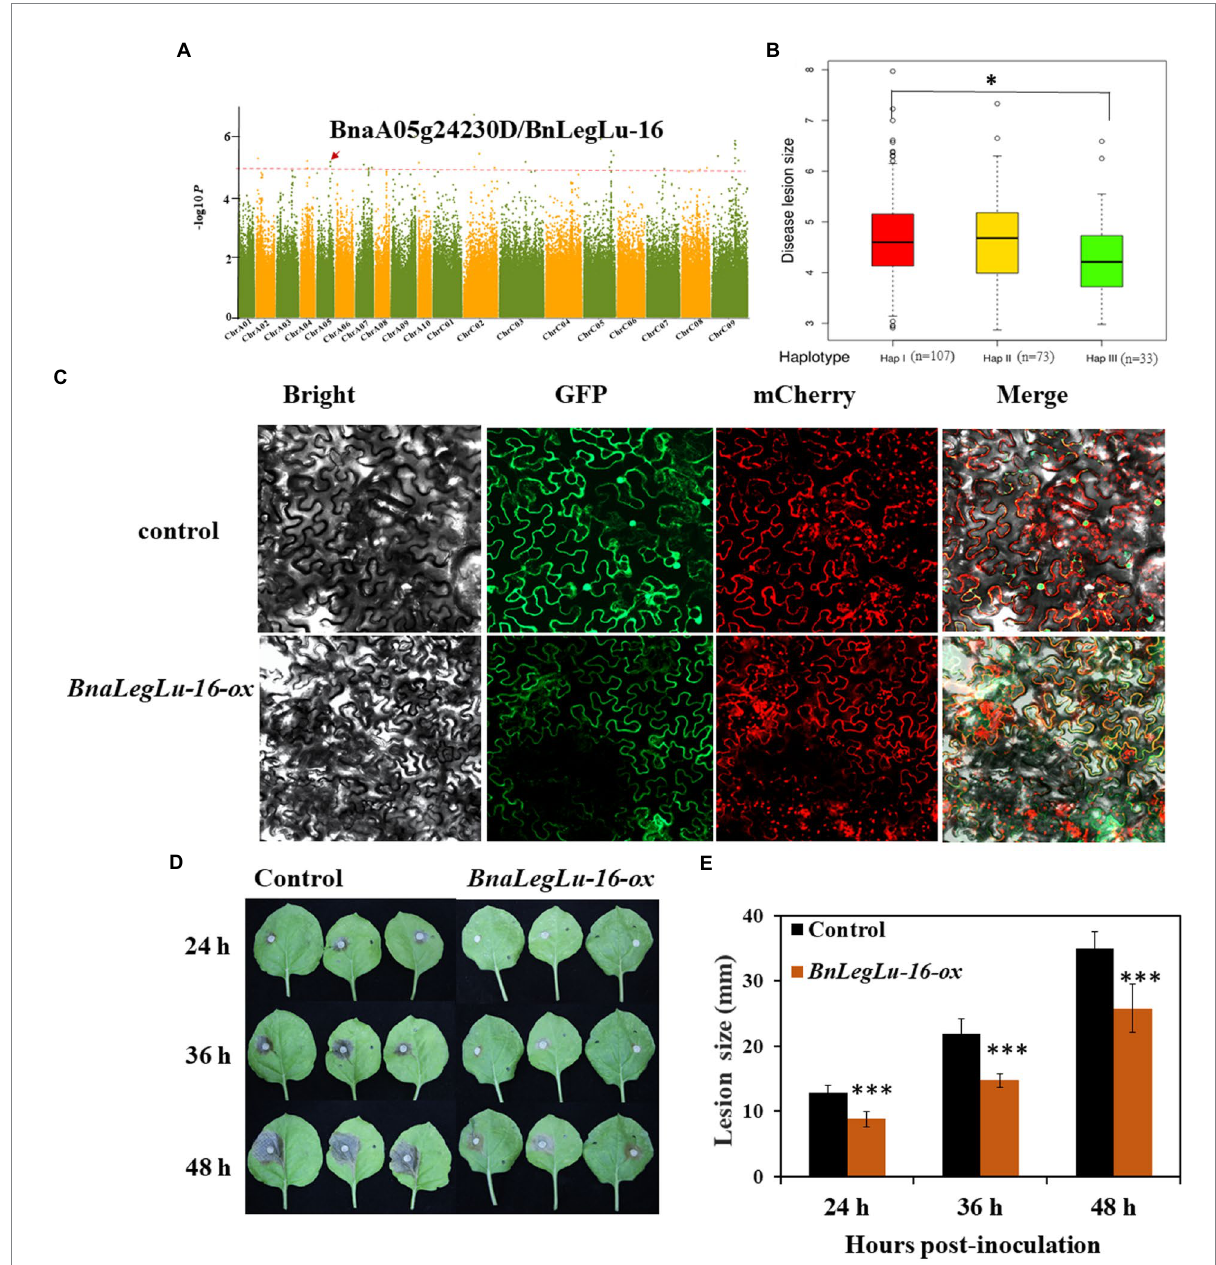
FIGURE 7 Functional validation of BnLegLu-16 for SD resistance. (A) Genome-wide association analysis (GWAS) for SD resistance in a B. napus population comprising 324 accessions and Manhattan plots of SD resistance from GWAS; Manhattan plots of the disease after 36 h; the red dashed line shows GWAS threshold (1/SNP number). (B) Haplotype analysis of BnLegLu-16 . (C) Subcellular localization of BnLegLu-16-ox in tobacco, BnLegLu-16- GFP fusion protein was transiently co-expressed with the mCherry–H + -ATPase, which was used as the plasma membrane marker in tobacco leaves. GFP and mCherry were transiently co-expressed as the control. After 48 h post-incubation, the tobacco leaves were observed with confocal microscope (ZEISS LSM710, Germany). (D) Disease lesion sizes on leaves at 24, 36 and 48 hpi with S. sclerotiorum , which was transiently injected through agrobacterium containing BnLegLu-16-ox and the control into tobacco leaves. (E) Disease lesion sizes statistically analyzed by comparing the overexpression BnLegLu-16-ox to the control. The data represent the means ± 2 SD from three independent experiments, with each containing 20 leaves. Significant differences in lesion size between BnLegLu-16-ox and the control are indicated (Student’s t -test) as follows: *** p < 0.001). The error bars show the standard error of three